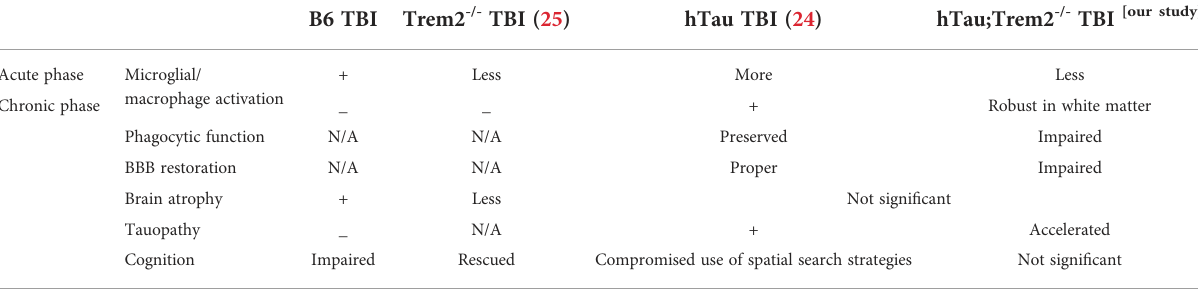
TABLE 1 TREM2 functions in different genetic